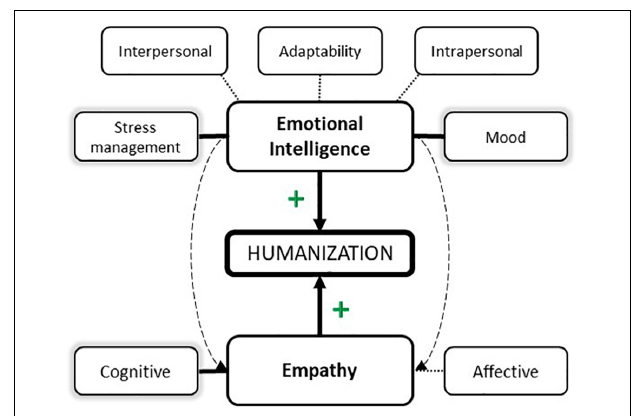
FIGURE 1 | Hypothetical model